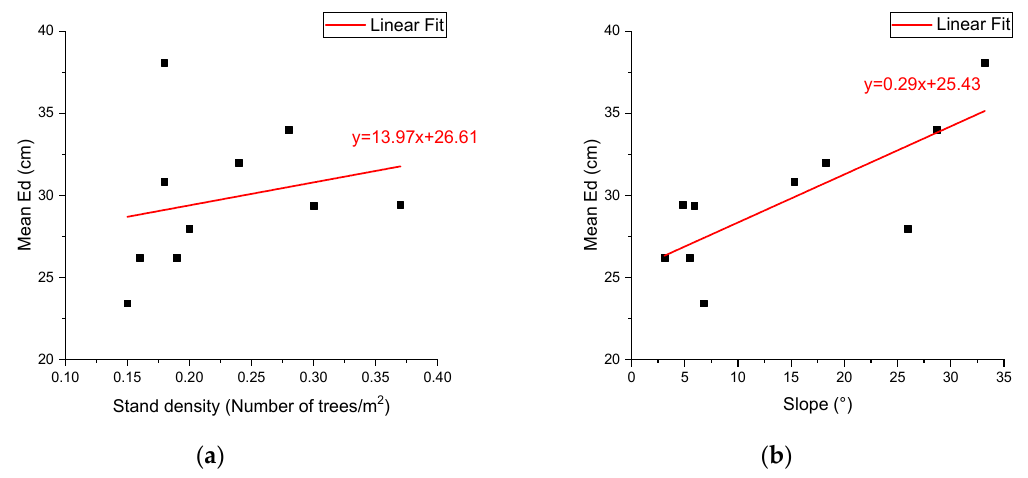
Figure 14. Scatter plot ( a ) between mean Ed and stand density ( b ) and slope.